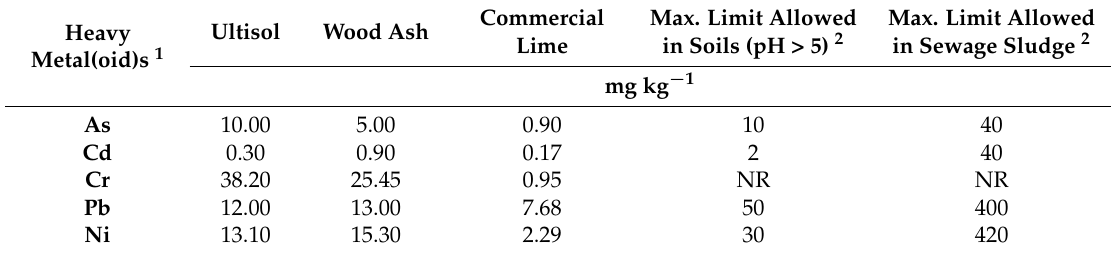
Table 2. Psuedo-total contents of heavy metal(oid)s in the Ultisol, wood ash, and commercial lime.